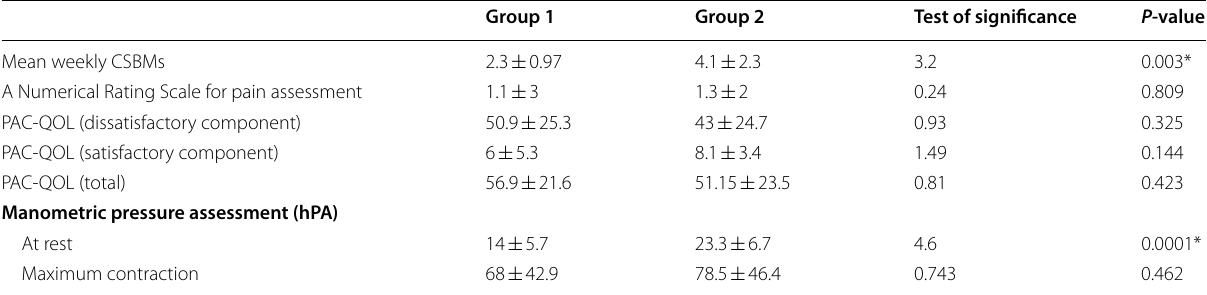
hPa : hectopascal (it is the unit of pressure, and it is equal to 100 Pa), CSBMs Complete spontaneous bowel movements, PAC-QOL Patient Assessment of Constipation Quality of Life questionnaire Significant P 0.05 ≤ * P -value of the independent t